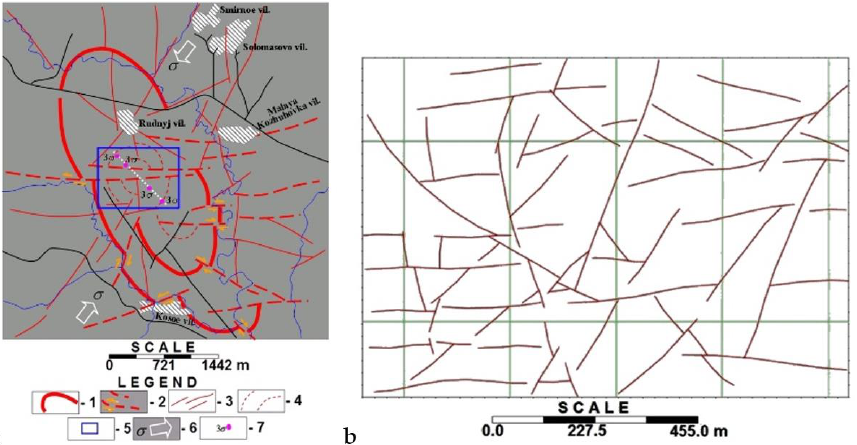
Figure 4. Mid-scale and detailed geostructural reconstructions in the vicinity of the construction area: ( a ) detailing the image of ellipsoid of deformations (1 — elliptical contour of stressed rock massif; 2 — geodynamic zones with shear kinematics; 3 — elements of fracture tectonics of unknown kinematics (low-contrast); 4 — arch regional lineaments; 5 — contour of investigated area; 6 — normal stress; 7 — generalized position of stress concentrators within investigated area); ( b ) large-scale geodynamic zones detailing based on combined decoding of remote sensing data (IR-band) and digital elevation model.